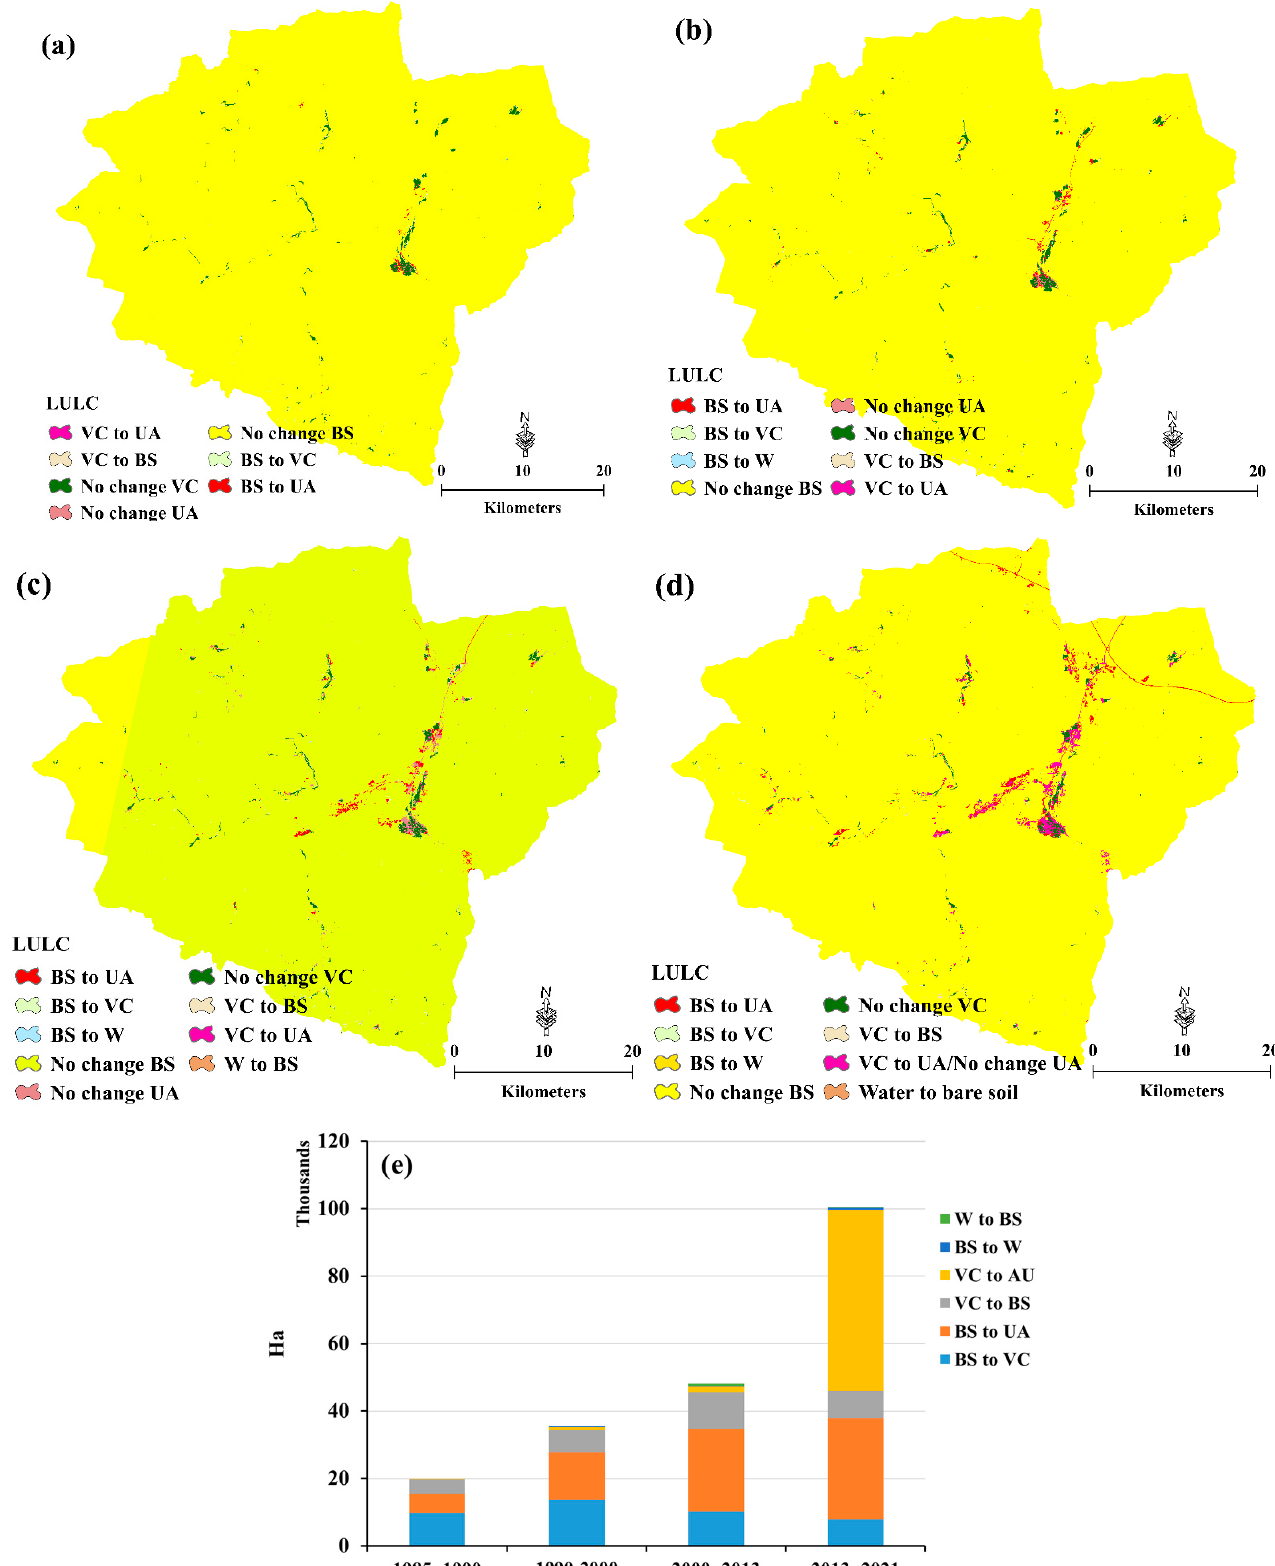
Figure 10. LULC in Al-Rustaq ( a ) 1985–1990, ( b ) 1990–2000, ( c ) 2000–2013, ( d ) 2013–2021, and ( e ) the overall LULC changes for 1985–2021 (BS = Bare Soil; VC = Vegetation Cover Soil; UA = Urban Area; W = Water).